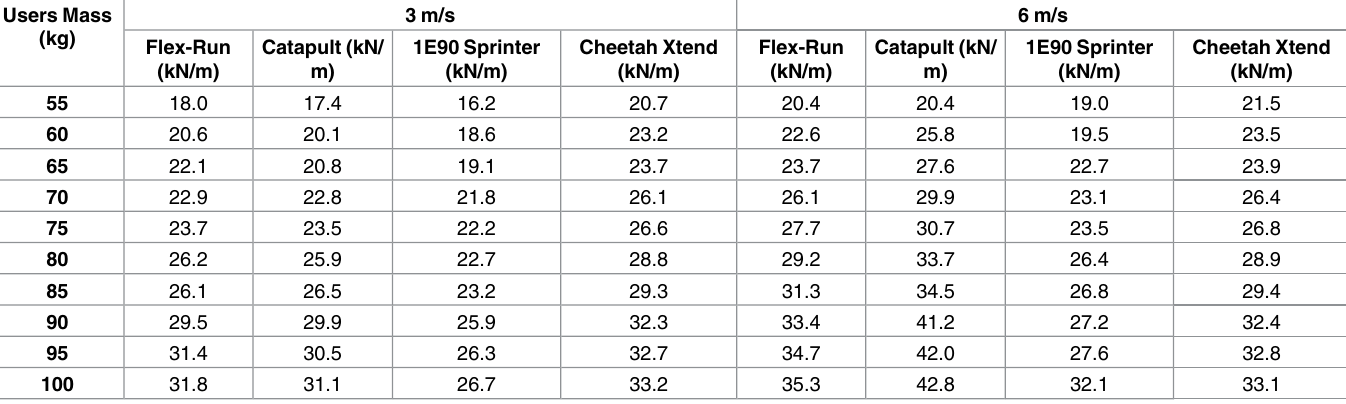
Table 2. The manufacturer recommended averageprosthetic stiffness across models based on running 3 m/s and 6 m/s. All values includethe rub- ber sole that comes with the prosthetic model, with the exceptionof the O¨ ssur CheetahXtend, which was equippedwith the O¨ ssur Flex-Run’srubber sole. Users Mass 3 m/s 6 m/s (kg) Flex-Run